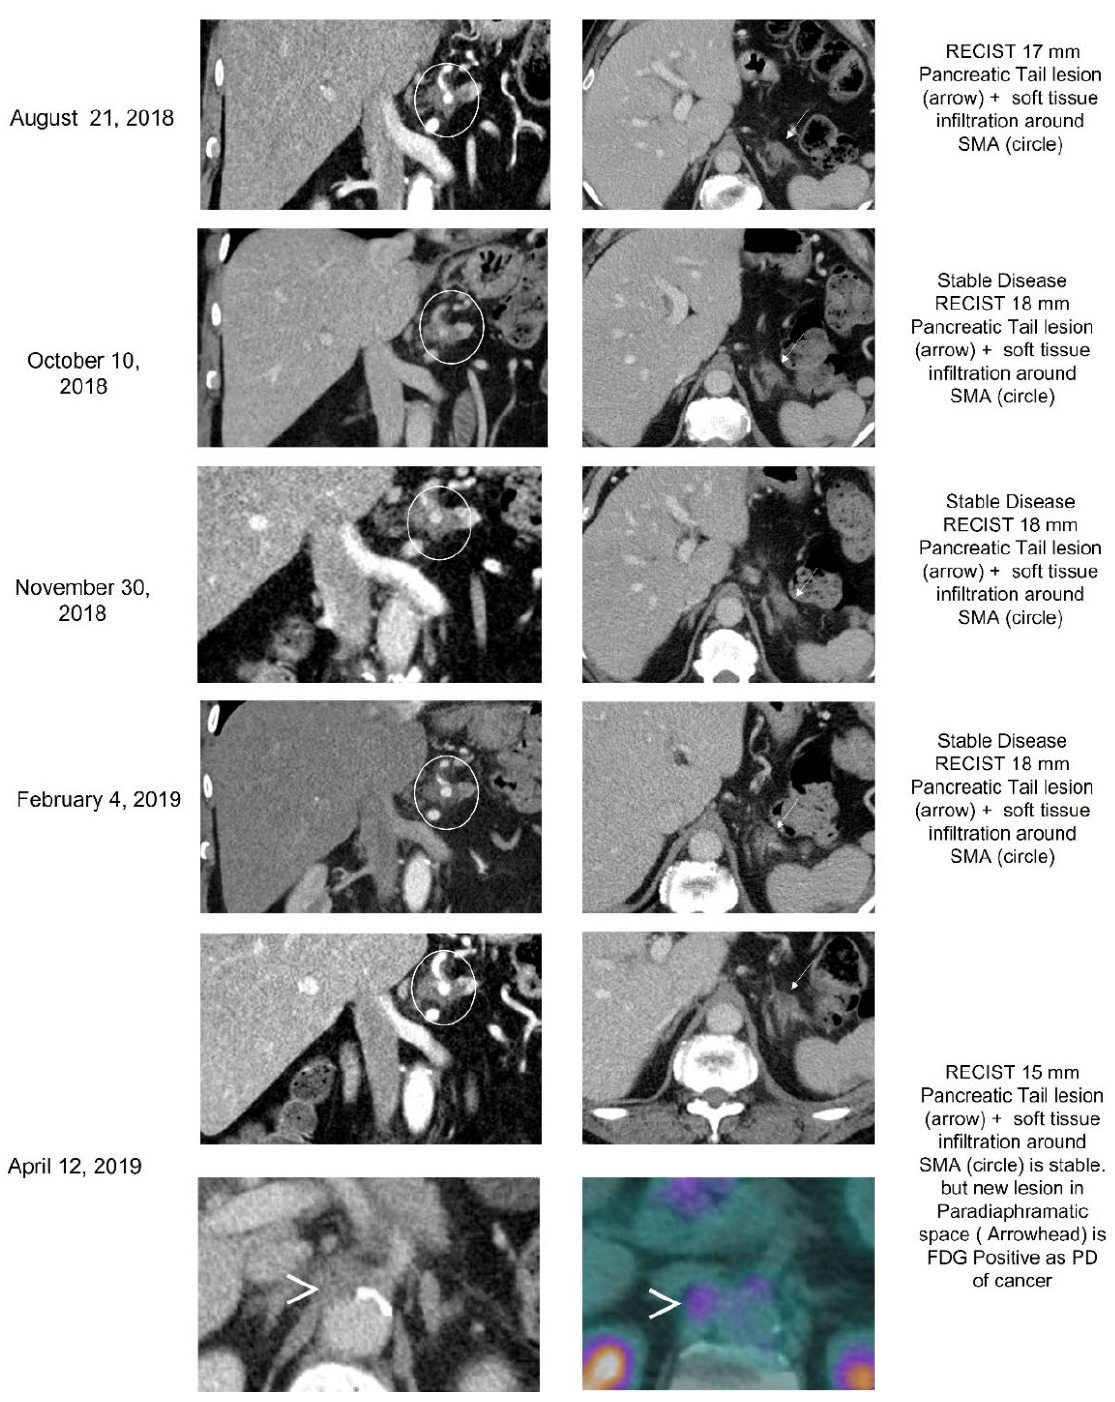
Figure 4. Case 3 treatment responses. Legend: Treatment with MMC resulted in stable disease in the pancreatic tail primary lesion (arrow). The soft tumor tissue around superior mesenteric artery was also stable (circle). On April 2019 disease progression was observed, with a new para diaphragmatic lesion, later was confirmed as a lung cancer